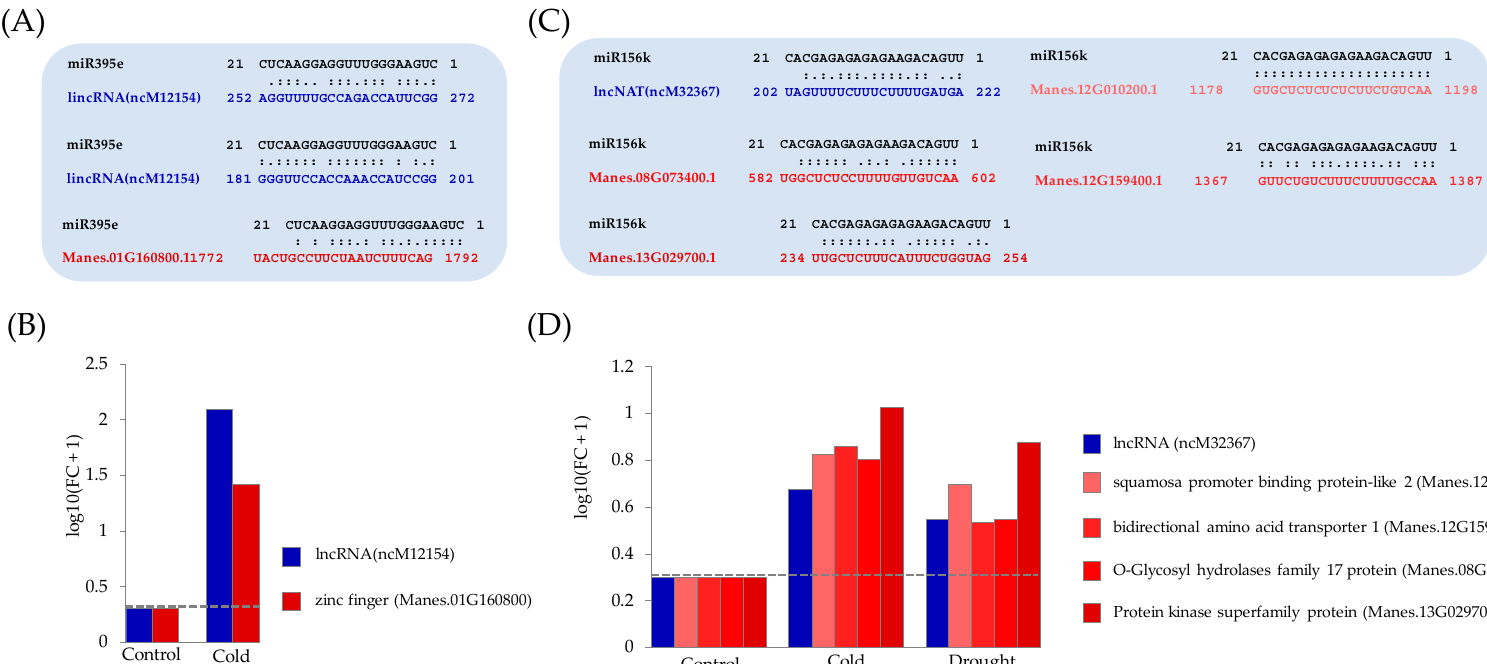
Figure 8. Potential novel lncRNA responded in cold and / or drought stress conditions by a trans -regulatory relationship through miRNA target mimicry. ( A ) Binding site of miR395e on lncRNA, ncM12154, and zinc finger (CCCH-type) family protein mRNA (Manes.01G160800.1). ( B ) Fold change (FC) of lncRNA, ncM12154, and target gene encoded for zinc finger (CCCH-type) family protein (Manes.01G160800) under control and cold stress conditions. ( C ) Binding site of miR156k on lncRNA (ncM32367) and SQUAMOSA-promoter binding protein-like 2 mRNA (Manes.12G010200.1), bidirectional amino acid transporter 1 mRNA (Manes.12G159400.1), O-Glycosyl hydrolases family 17 protein mRNA (Manes.08G073400.1), and protein kinase superfamily protein mRNA (Manes.13G029700.1). ( D ) Fold change (FC) of lncRNA, ncM32367, protein-coding gene encoded for SQUAMOSA-promoter binding protein-like 2 (Manes.12G010200), bidirectional amino acid transporter 1 (Manes.12G159400), O-Glycosyl hydrolases family 17 protein (Manes.08G073400), and protein kinase superfamily protein (Manes.13G029700) under control, cold, and drought stress conditions. FC control = Expression control / Expression control ; FC cold = Expression cold / Expression control ; FC drought = Expression drought / Expression control .